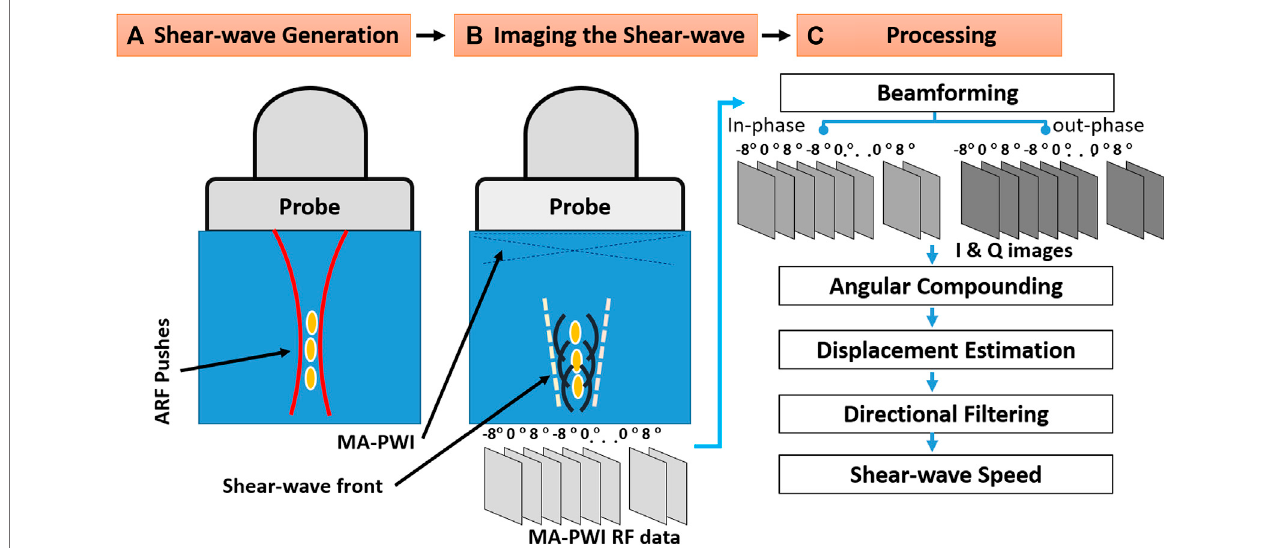
FIGURE 1 | Schematic of shear-wave elasticity imaging: (A) shear-wave generation; (B) tracking the shear-wave using multi-angle plane wave imaging (MA-PWI); and (C) data processing to estimate the shear-wave speed (SWS).